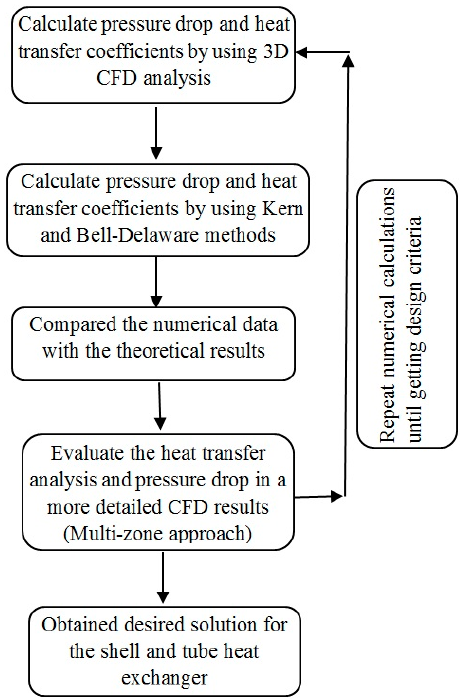
Figure 7. Flow chart of numerical method for the desired solution of the thermal analysis of a shell and tube heat exchanger suggested in this study.